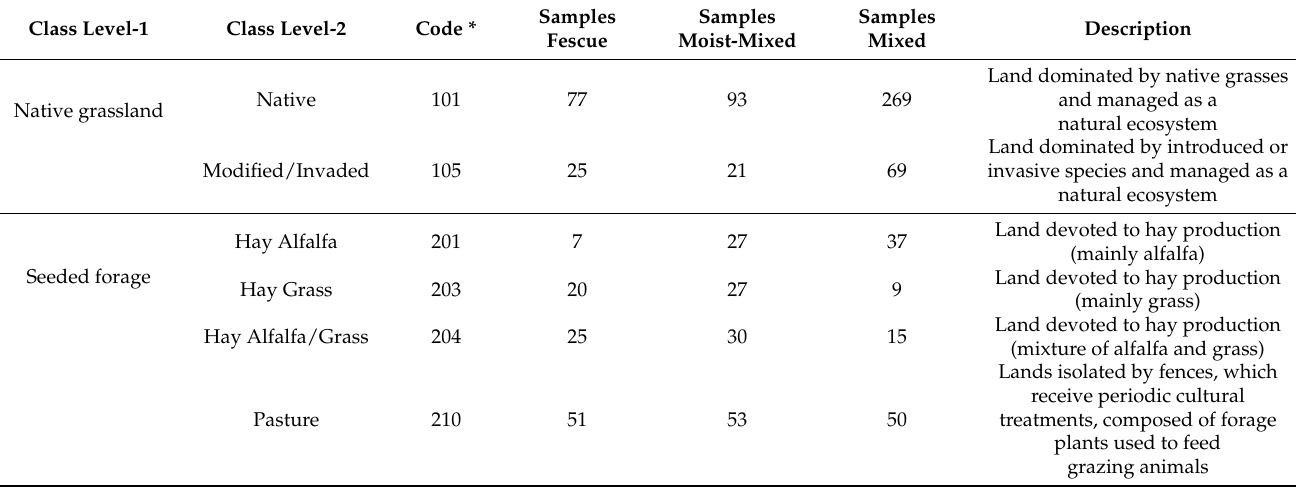
Table 1. Description of the grassland/forage classes used in this